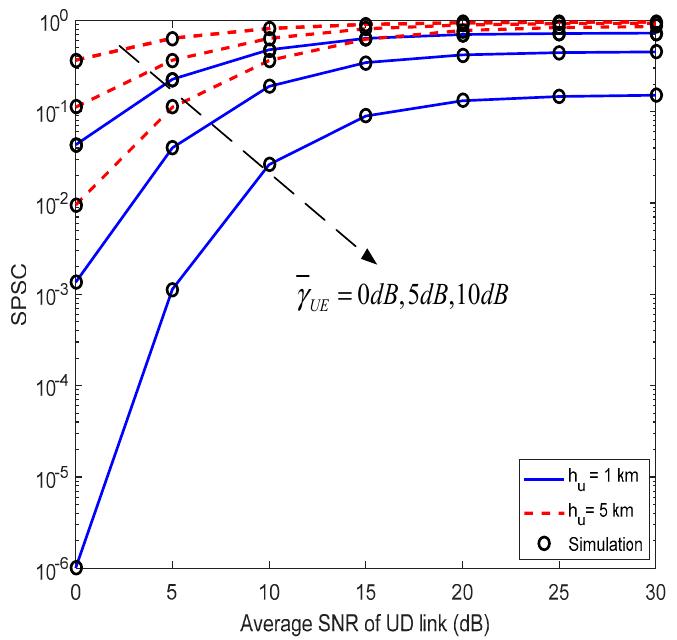
Figure 7. The impact of eavesdroppers average SNR on the network SPSC at different values of UAV height under γ BU = 5 dB and ρ e = 4 × 10 − 2 .